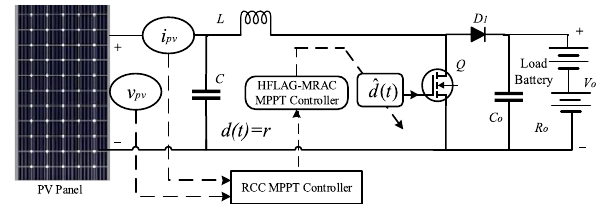
Figure 7. Representation of PV system with proposed 2-level MPPT control